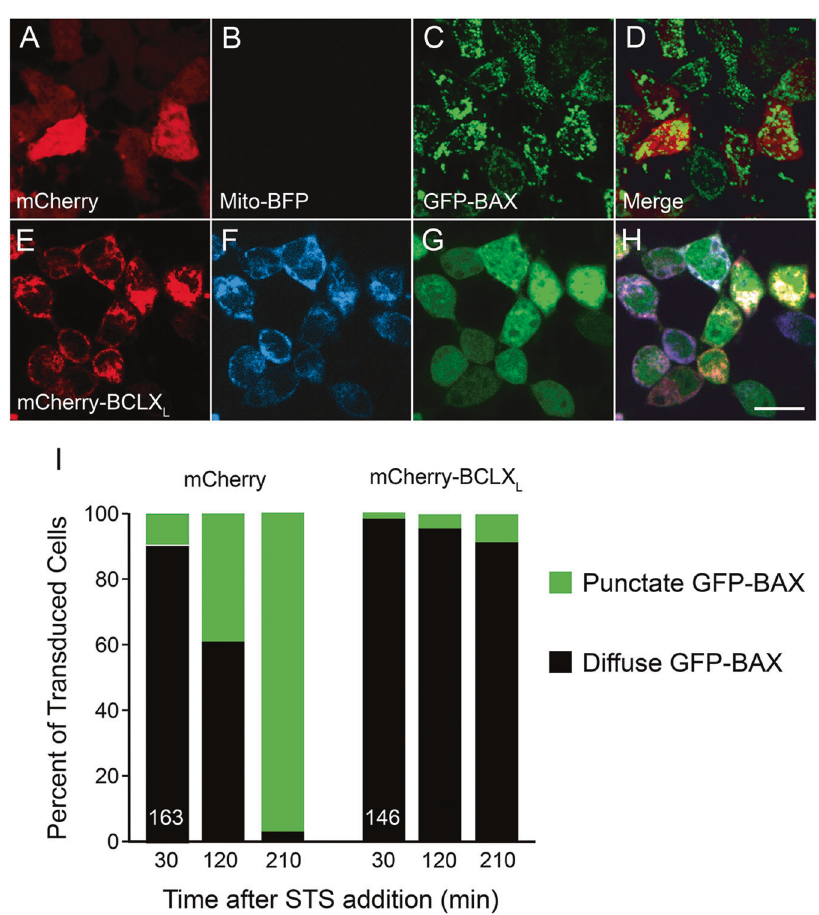
Fig. 1 mCherry-BCLX L colocalizes with the mitochondria and prevents BAX recruitment in vitro. Representative images of D407 cells expressing mCherry ( A – D ), mCherry-BCLX L ( E – H ) along with mitoBFP and GFP-BAX 3.5 h after treatment with 1 µM staurosporine (STS). Note that mitoBFP fl uorescence is rapidly lost when the mitochondrial outer membrane becomes permeabilized and the mitochondria become fragmented, which is why B has dramatically reduced fl uorescence. Scale bar = 10 µm. Live cell imaging was used to track the localization of GFP-BAX for 3.5 h after STS treatment. The percentage of cells in each condition with punctate localization is quanti fi ed in I . N = 163 and 146 cells for the mCherry and mCherry-BCLX L expressing groups, respectively. χ 2 test was used to assess the signi fi cance of the difference in percentage between each group at each time point. P < 0.0005 at 30 min, P < 0.00001 at 120 min, and P < 0.00001 at 210